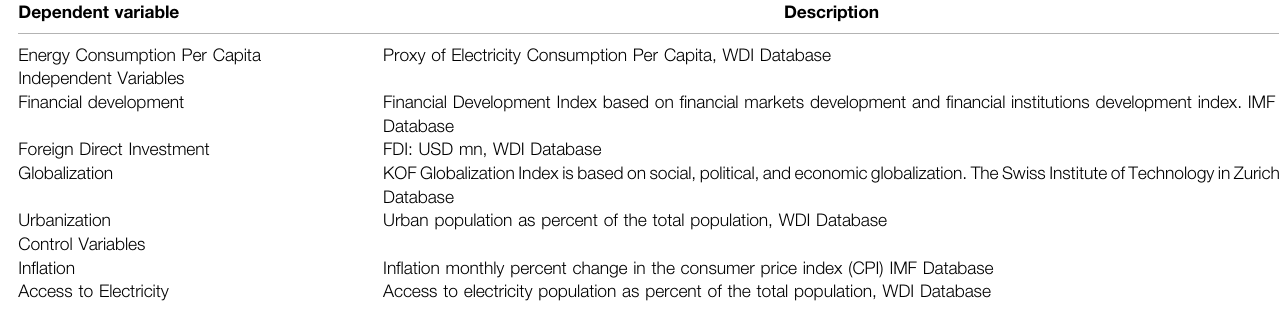
TABLE 1 | Measurement of